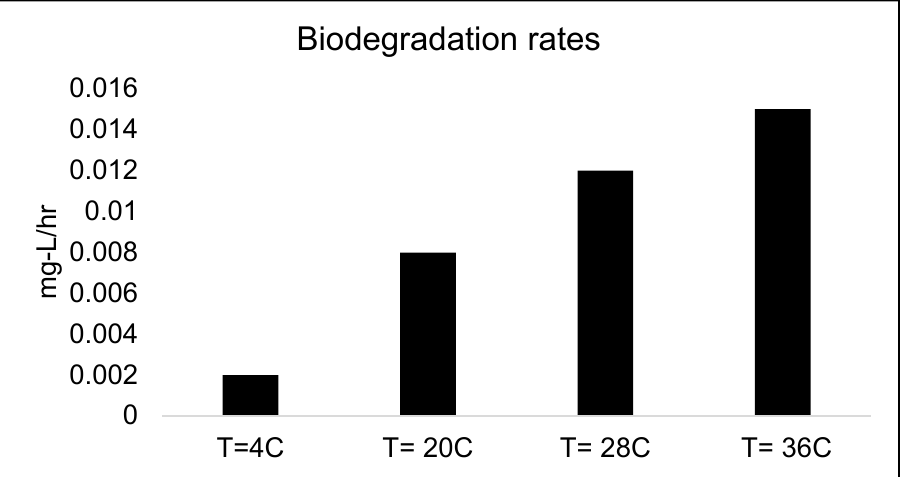
Figure 7. Estimated biodegradation rate of NAPL in column setup for port P1 at different soil-water temperature levels. P1 is sampling top sampling port.